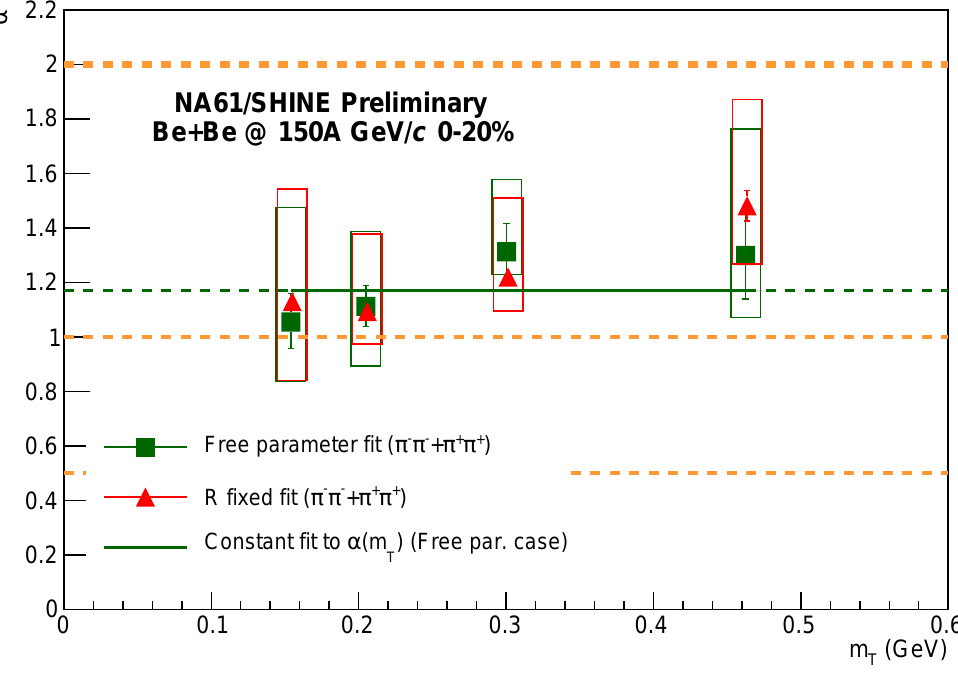
Figure 2. Lévy exponent α versus transverse mass: comparison between free parameter fit, fit with R fixed and fit with α fixed. The boxes represent systematic uncertainties. For each bin, the results are slightly shifted to the right for visibility, but they are in the same